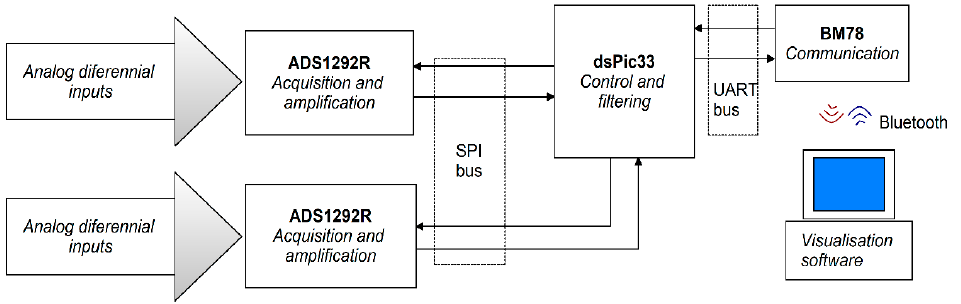
Figure 7. Block diagram of acquisition device.